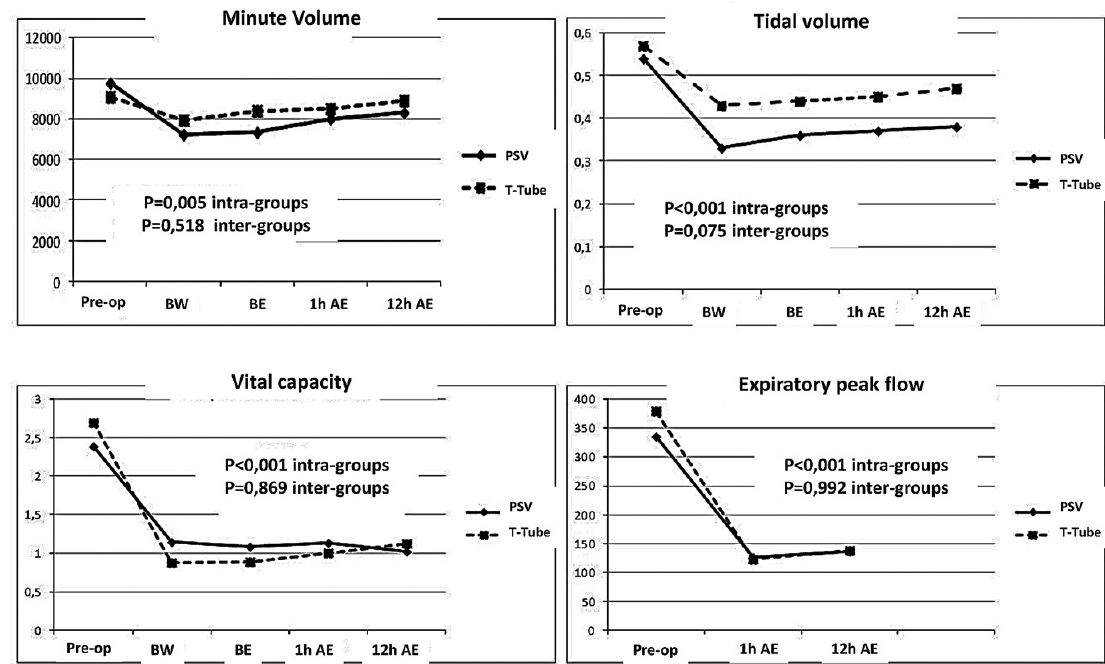
Fig. 1 - Perioperative evolution of the minute volume, tidal volume vital capacity and expiratory peak flow. Preo-op: preoperative; BW: before weaning; BE: before; 1h AE: 1 hour after extubation; 12h AE: 12 h after